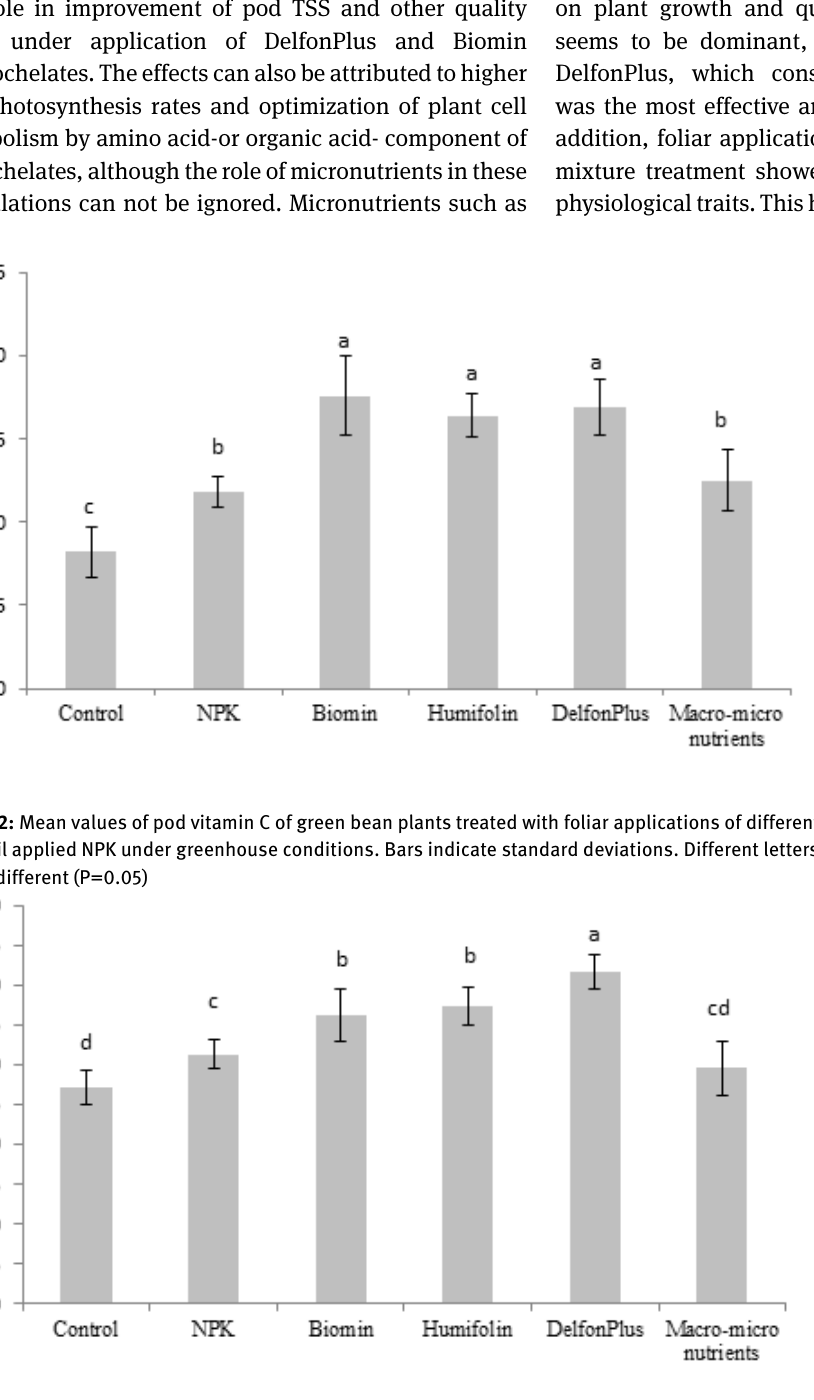
Figure 3: Mean value of pod protein content of green bean plants treated with foliar applications of different organic chelates, a mix of nutri- ents and soil applied NPK under greenhouse conditions. Bars indicate standard deviations. Different letters across all foliar treatments are statistically different